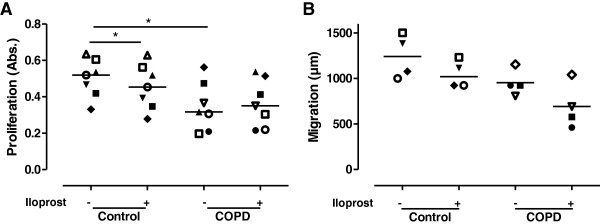
Iloprost treatment did not change migration capacity or proliferative rate in control or COPD fibroblasts. Proliferative rate of distal lung fibroblasts from control subjects (n = 7) and patients with COPD (n = 7) (A). All proliferation experiments are the mean of quintuplicate. Cells were stimulated with iloprost (100 nM) in fibroblast medium containing 0.4% serum pretreated with indomethacin (3 μM). Fibroblast medium containing 10% serum was used as internal control. Migration capacity in distal lung fibroblasts from control subjects (n = 4) and patients with COPD (n = 4), *p < 0.05 (B). All migration assays are the mean of triplicates. Data are presented as median with individual values and median values are represented as a line. Statistical analysis is performed with Mann Whitney test to compare differences between control and COPD fibroblasts and Wilcoxon paired rank sum test is used to analyze differences within the control and COPD fibroblasts after iloprost stimulation.